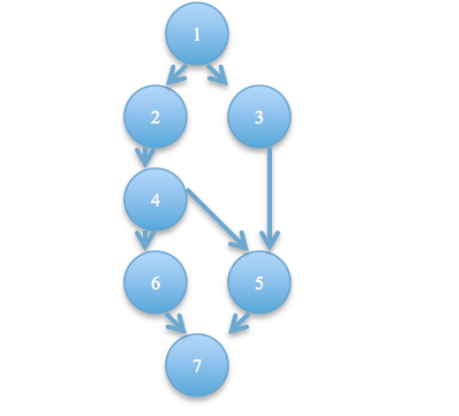
Figure 7. A graph G = ( V , E ) representing a tree of milestones for a group task, where V is the set of milestones and E is the set of milestone